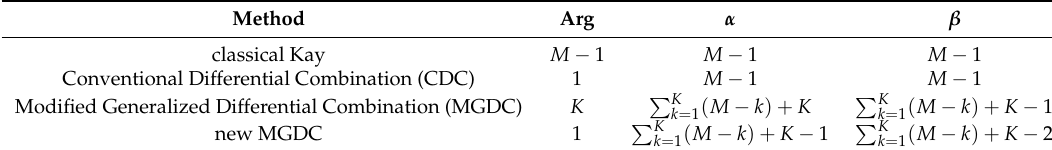
Table 1. The computation complexity of different